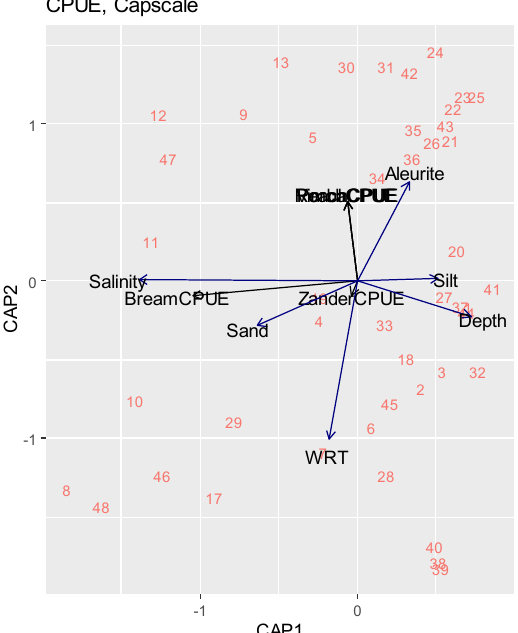
Figure 8. A distance-based redundancy analysis (CAPSCALE) biplots of environmental factors and by CPUE interaction in each fishing square. ZanderCPUE, BreamCPUE, RoachCPUE, and VimbaCPUE, PerchCPUE are the CPUE of corresponding fish species in the particular fishing square. The explanatory variables include sediment type, average depth, average salinity, and water residence time (WRT) in FS. Numbers represent ordinated fishing squares.